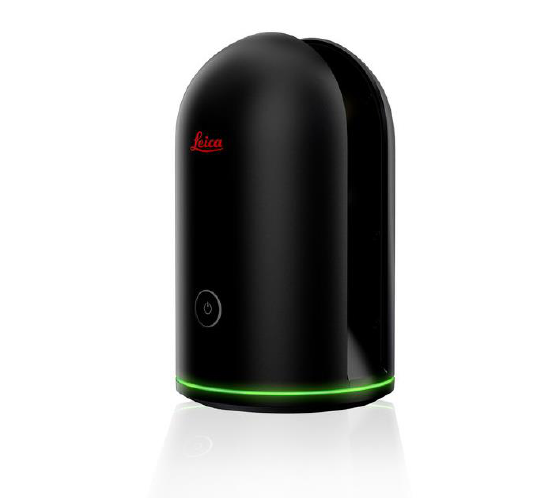
Figure 1 . Laser scanner Leica BLK360 (Leica Geosystems, 2022).